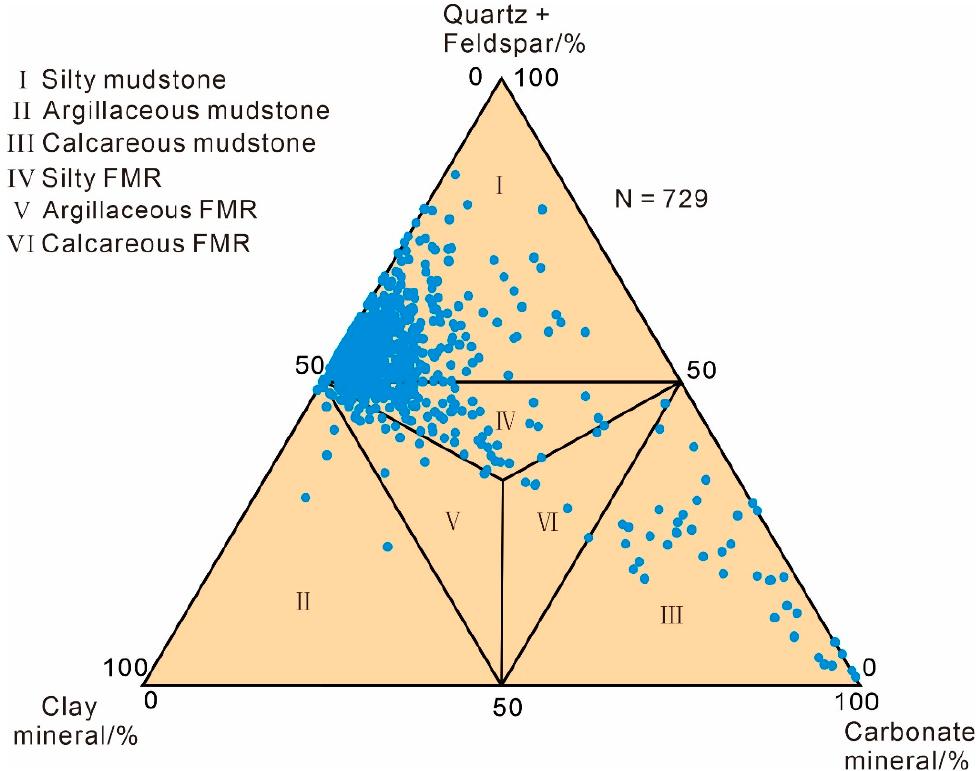
Figure 5. Ternary diagram showing the mineralogical composition of the FGSRs in the Qingshankou Formation. Note that FMR = fine mixed sedimentary rock.